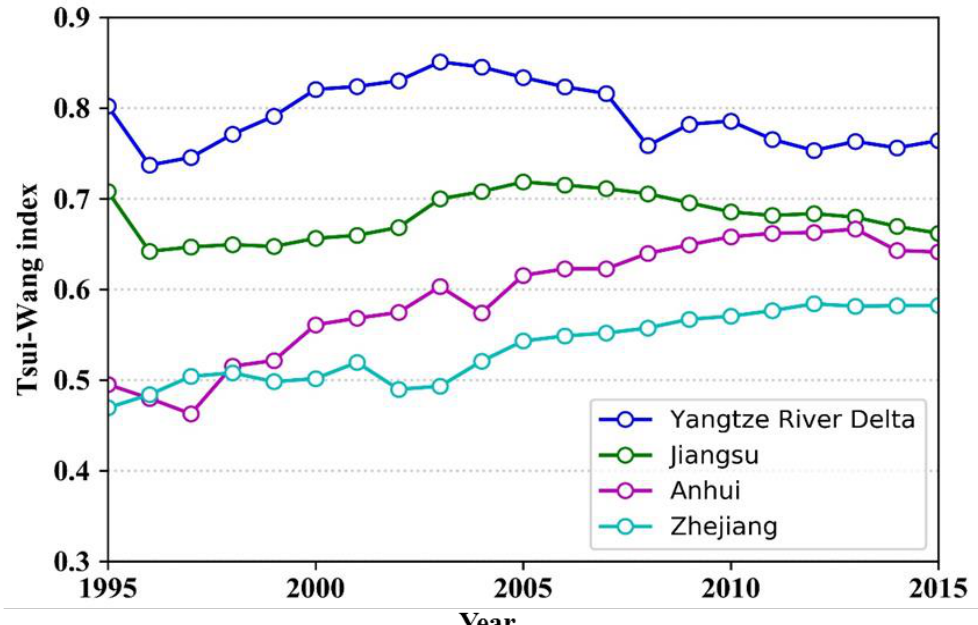
Figure 7. Comparison of the Tsui–Wang index of each province in the YRD region from 1995 to 2015.